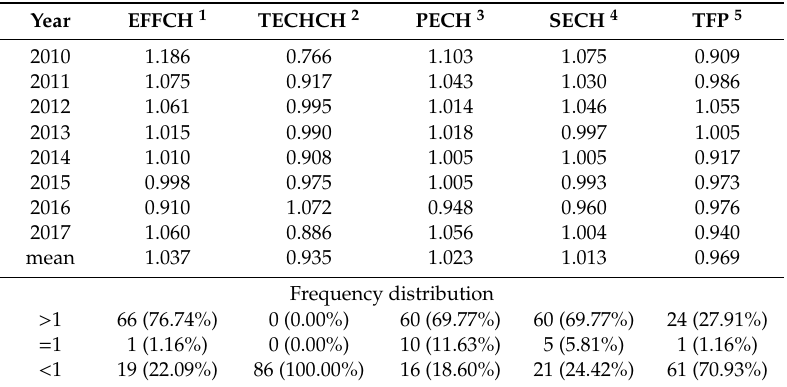
Table 4. Results of the Malmquist index model